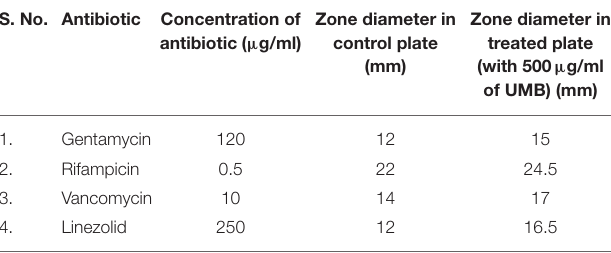
TABLE 3 | Zone of antibiotic susceptibility of MRSE in the absence and presence of UMB (at 500 µ